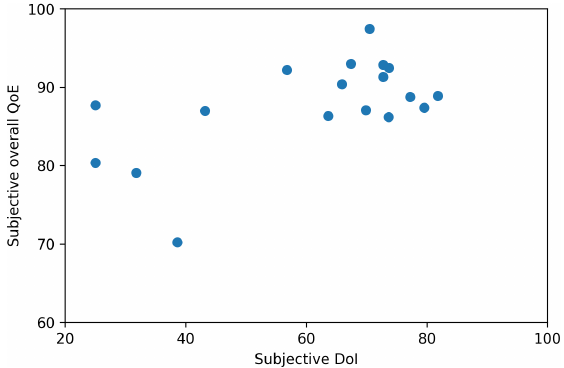
Figure 6. Scatter plot between the mean of subjective DoI scores and the subjective overall QoE obtained in the